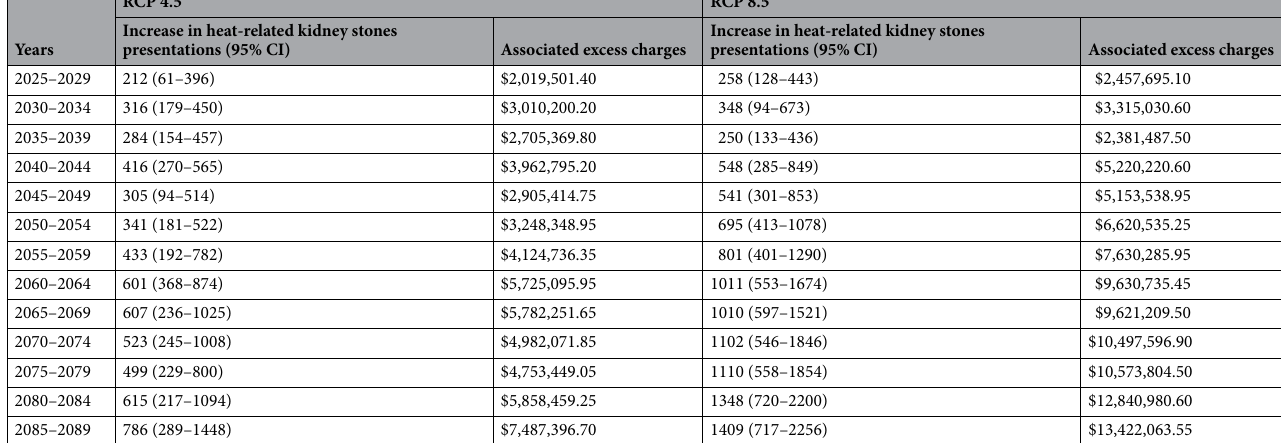
Table 3. Increase in the number of kidney stones attributed to heat (defined as WBT above 6.7 °C) and associated charges projected under RCP 4.5 and RCP 8.5 by 5-year interval between 2025 and 2089,